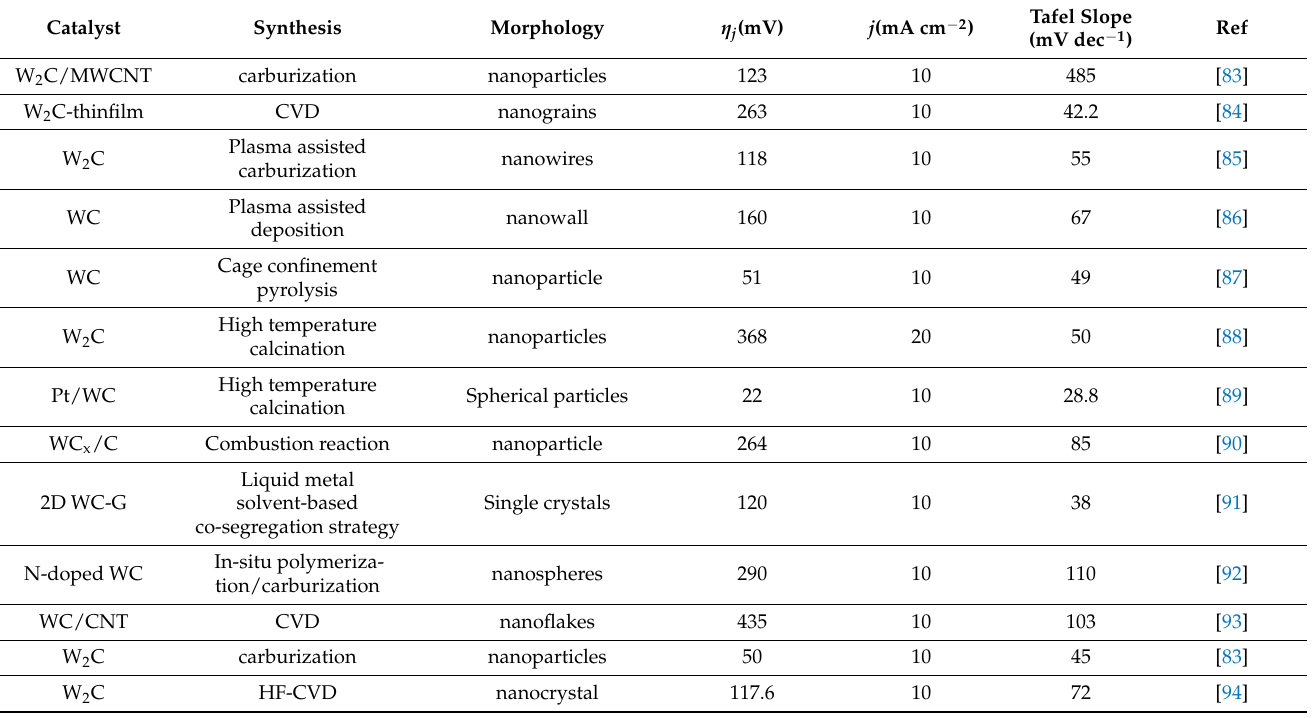
Table 2. Electrochemical characteristics of various W 2 C/WC-based electrocatalysts for improved HER